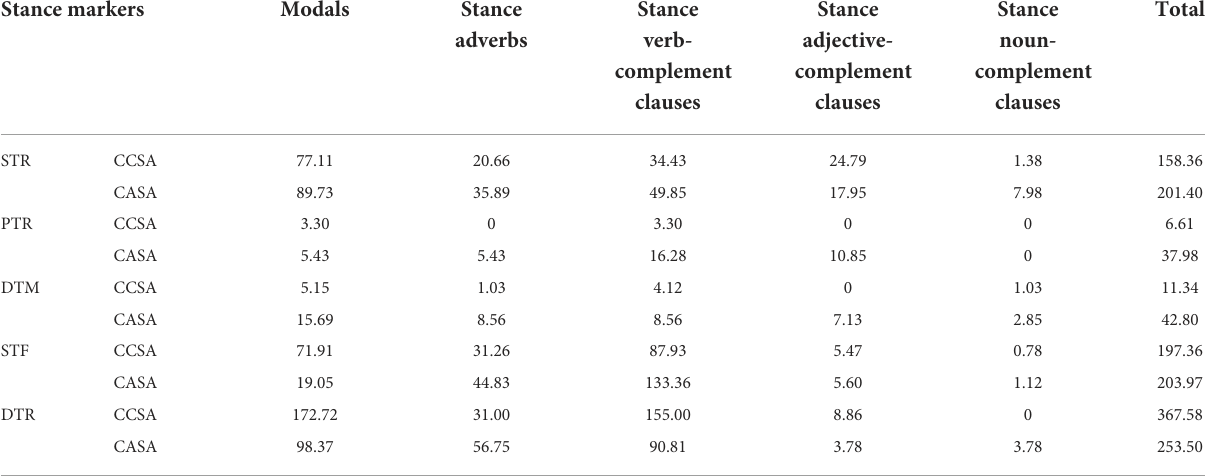
TABLE 7 Normalized frequencies of stance markers across five moves (per 10,000 words). Stance